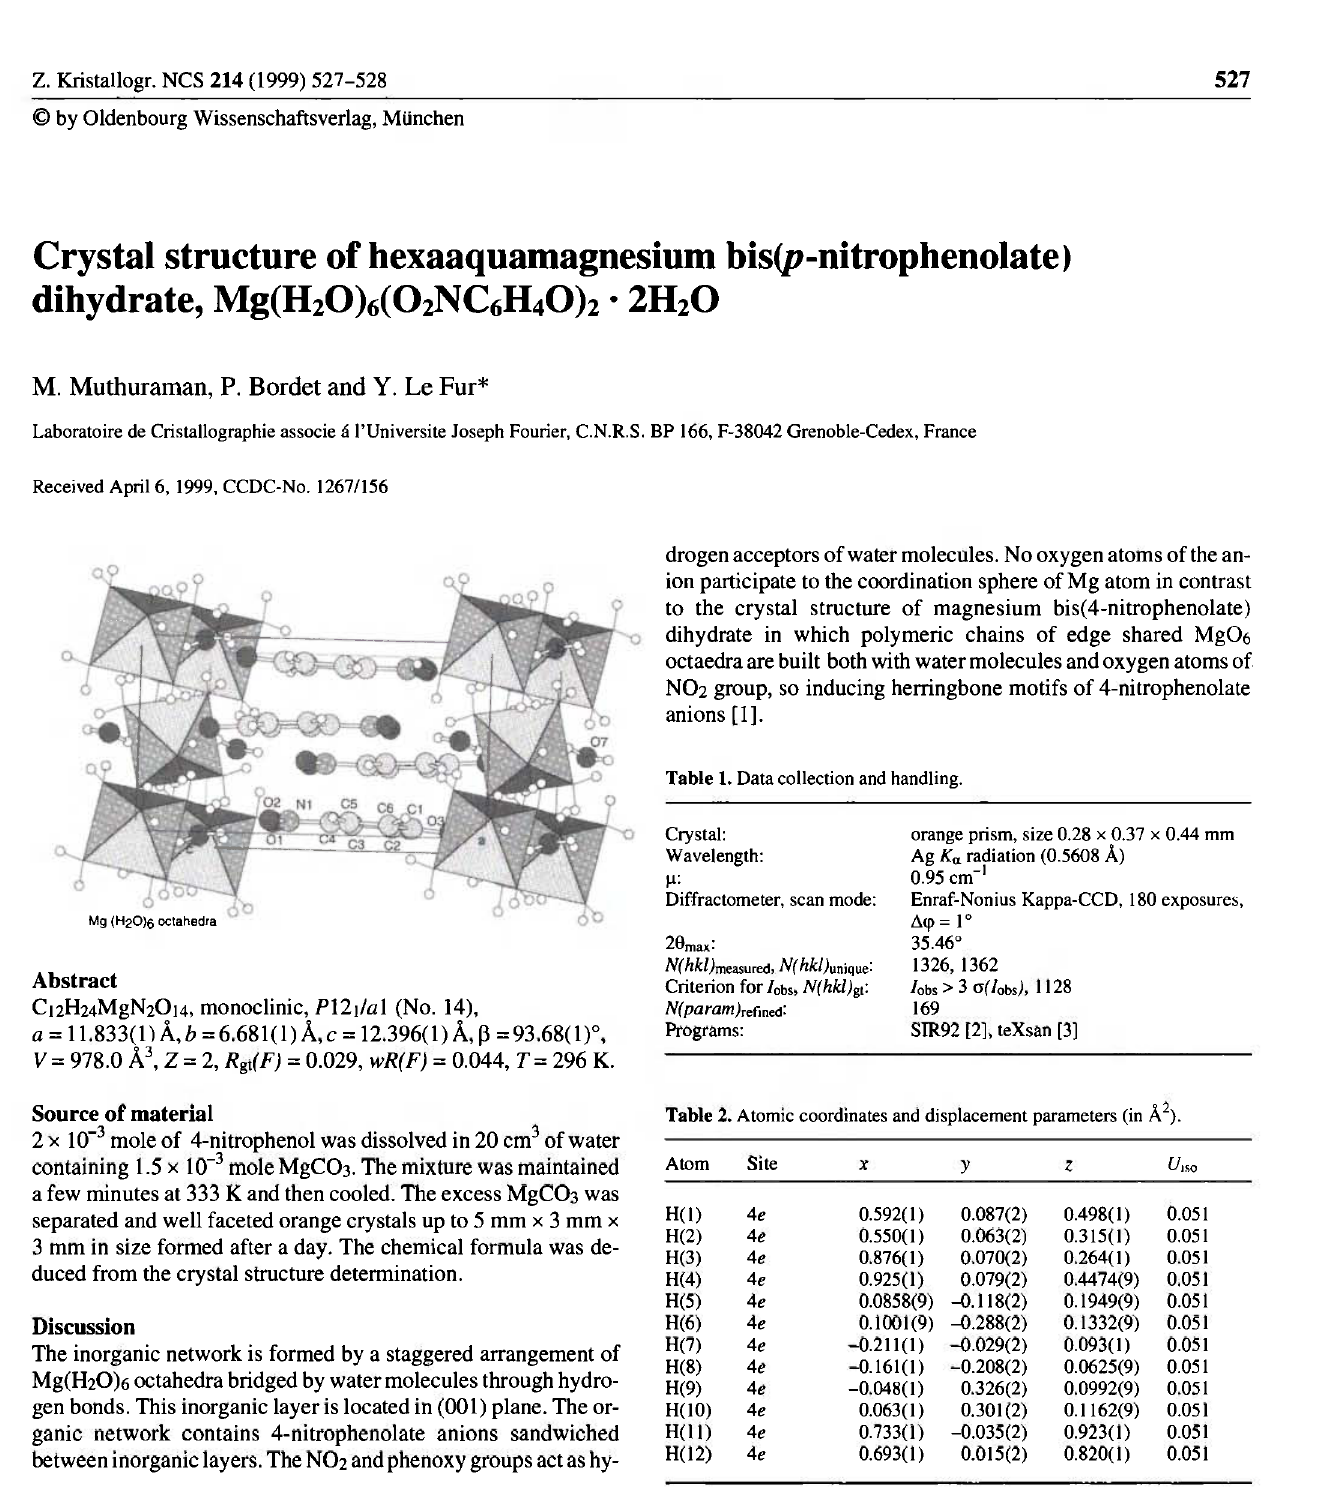
Table 3. Atomic coordinates and displacement parameters (in Ä 2 ).